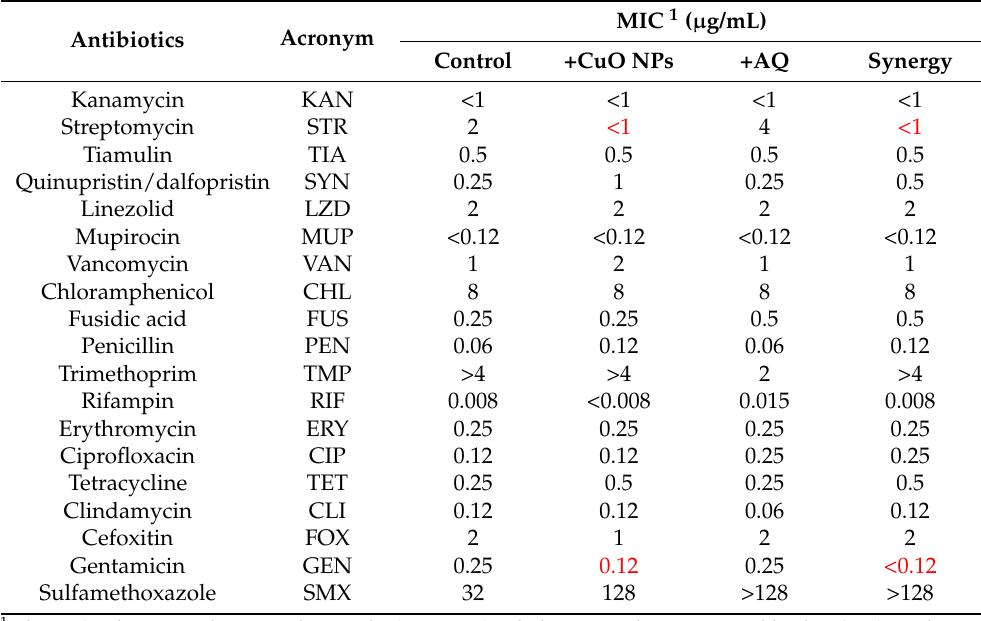
Table 3. Screening of antibiotics modulated by CuO NPs, AQ, or their